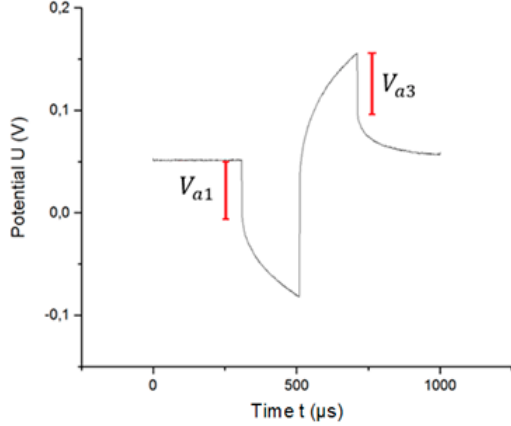
Figure 6. Different access voltages ( V a1 and V a3 ) in the potential transient.